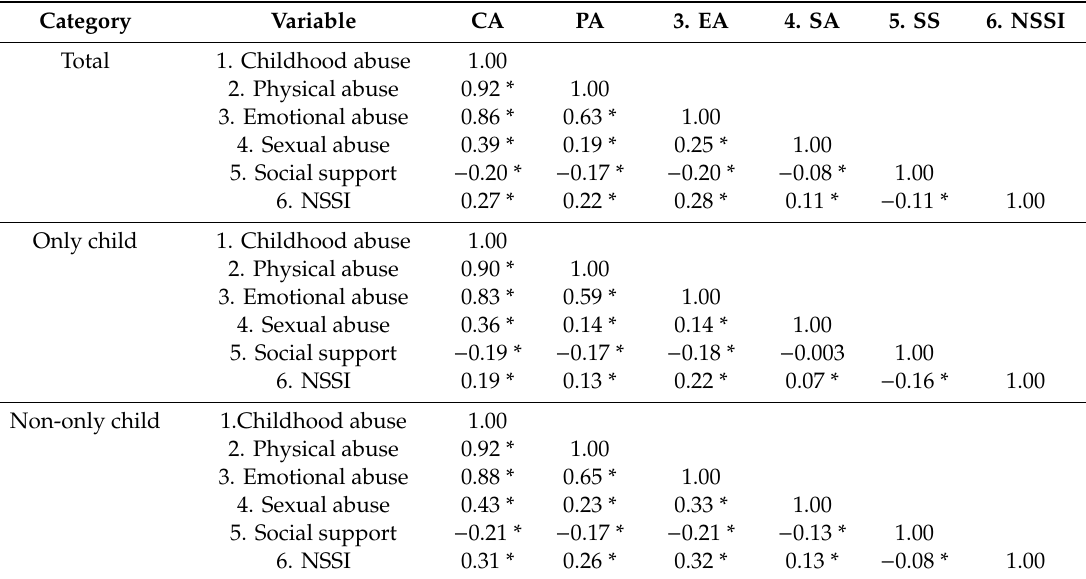
Table 2. Correlation analysis of child abuse, social support, and NSSI.